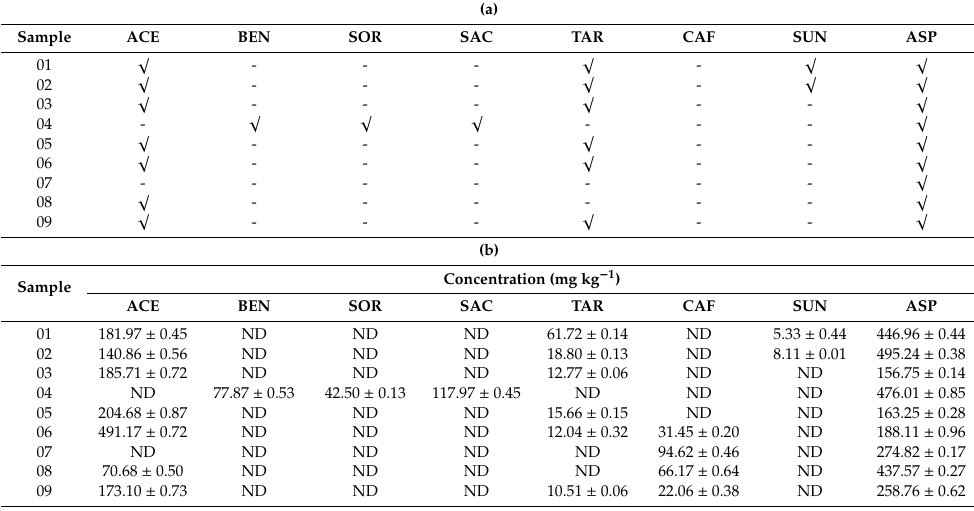
√ ” Listed − 1 − 1 ; BEN, max. 600 mg kg ; SOR,